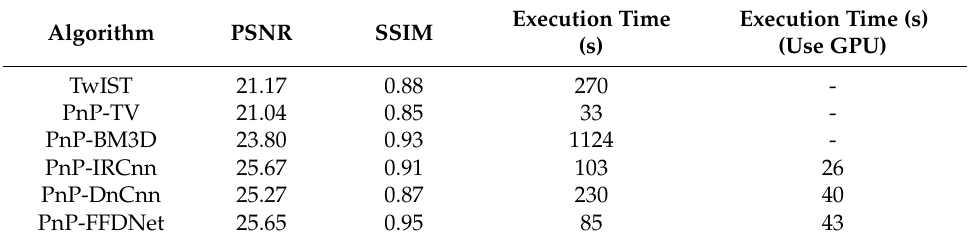
Table 4. Results of PSNR (dB), SSIM, execution time (s) and execution time (s) (use GPU) for different algorithms on real data.